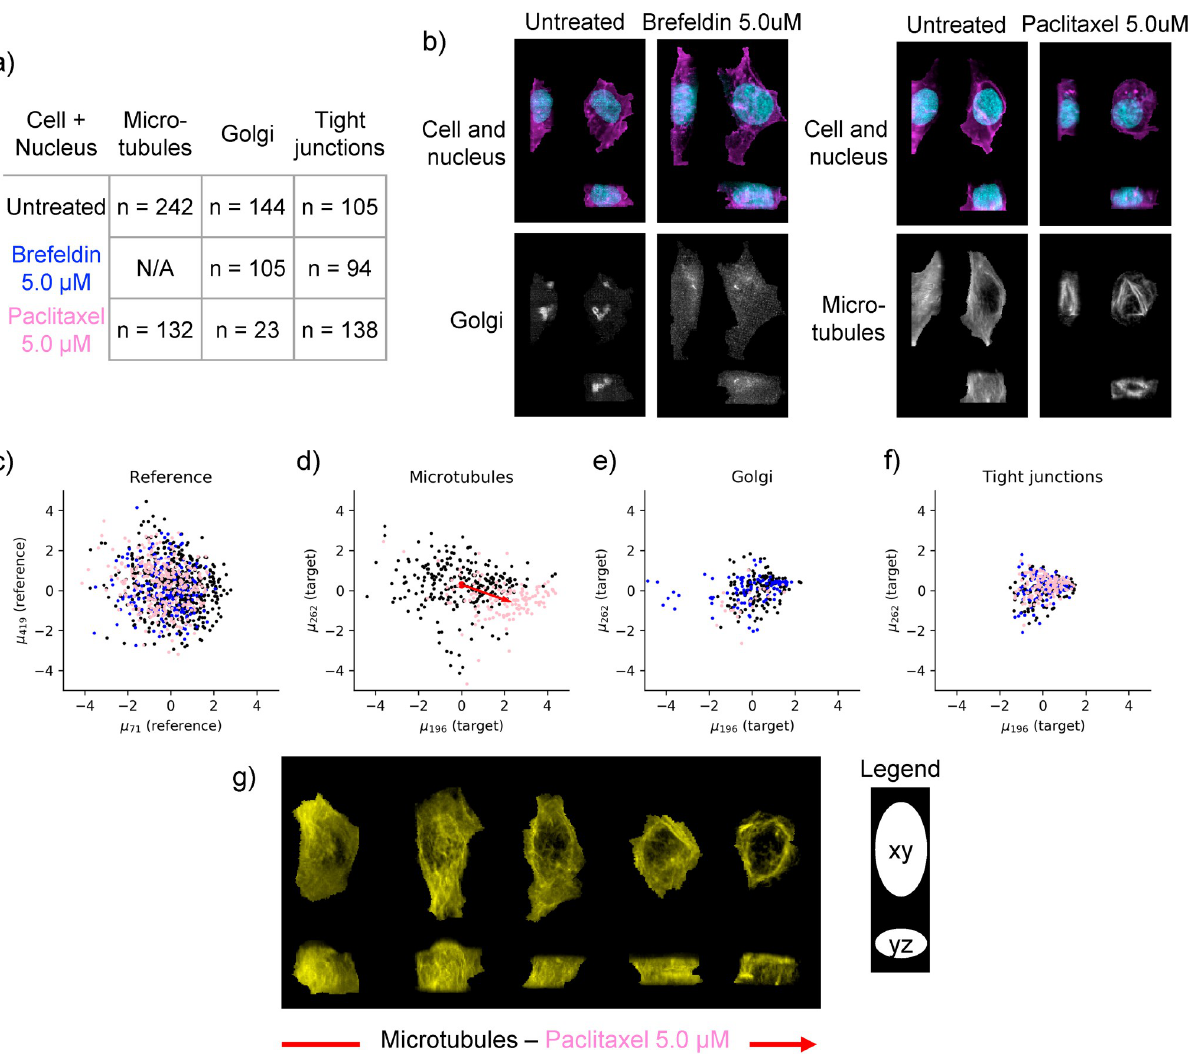
Fig 6. Analysis of drug perturbation data with the Statistical Cell. a) Experimental overview of drug-treated cells (rows) and measured subcellular structures (columns) where n indicates the number of obtained cells. Drugs are color-coded (Brefeldin is blue, Paclitaxel is pink). b) Maximum intensity projections of four real cells that are part of the drug perturbation study. For each cell the reference channels (nucleus in blue, cell membrane in magenta.) are visualized in the top, and the structure channel in the bottom. On the left: An untreated and Brefeldin-treated Golgi-tagged cell is shown. On the right: An untreated and Paclitaxel-treated Microtubules-tagged cell is shown. c) Scatter plot of cells embedded in first two dimensions of the reference latent space (cell + nucleus) of the Statistical Cell model. d) Microtubules-tagged cells embedded in the first two dimensions of the conditional latent space. The red arrow indicates the direction of the change of the centroid of the untreated (black) and treated (pink) populations. e) and f) Similar to d), but for Golgi and tight junctions, respectively. g) Visualization of microtubules for five real cells. For each cell we have visualized the maximum intensity projection along z, i.e. looking at the xy plane (top), and the maximum intensity projection along x, i.e. looking at the yz plane (bottom). These five cells are sampled at fixed intervals from the untreated(left)-to-treated(right) direction after projecting onto the red line in d).